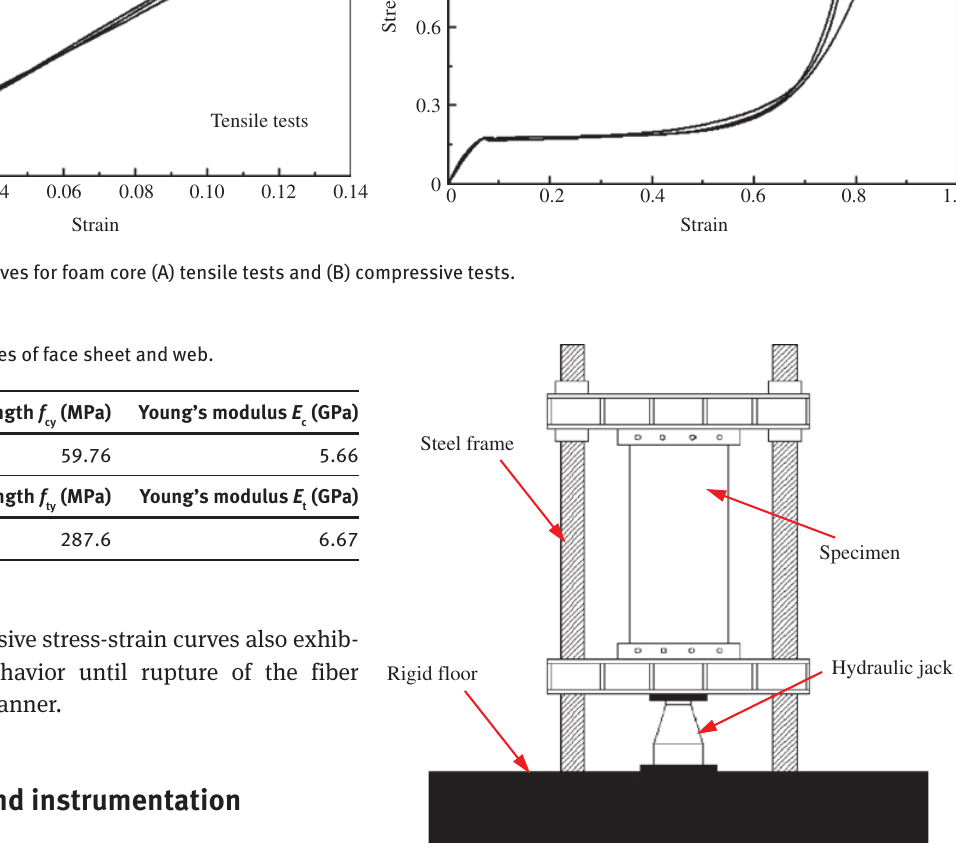
Figure 5: Schematic diagram of test setup for axial compression test.